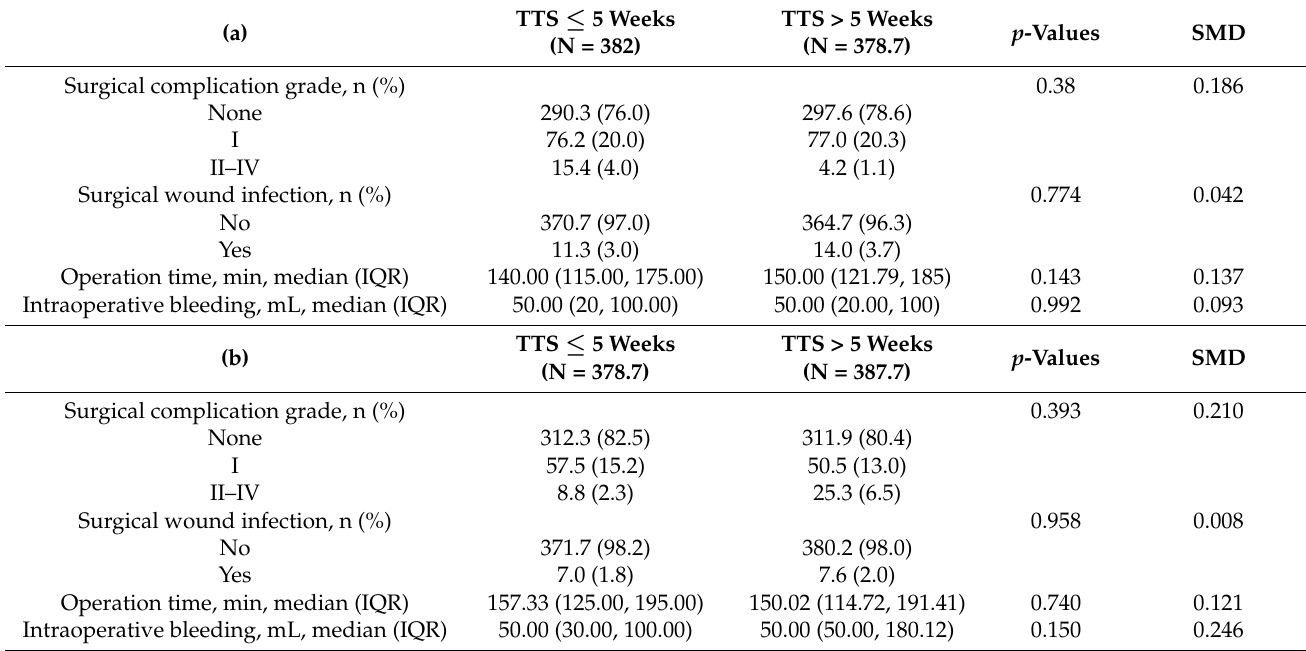
Table 5. ( a ). Comparison of short-term outcomes between two groups among T1a patients after IPTW (TTS = 5 weeks). ( b ). Comparison of short-term outcomes between two groups among T1b patients after IPTW (TTS = 5